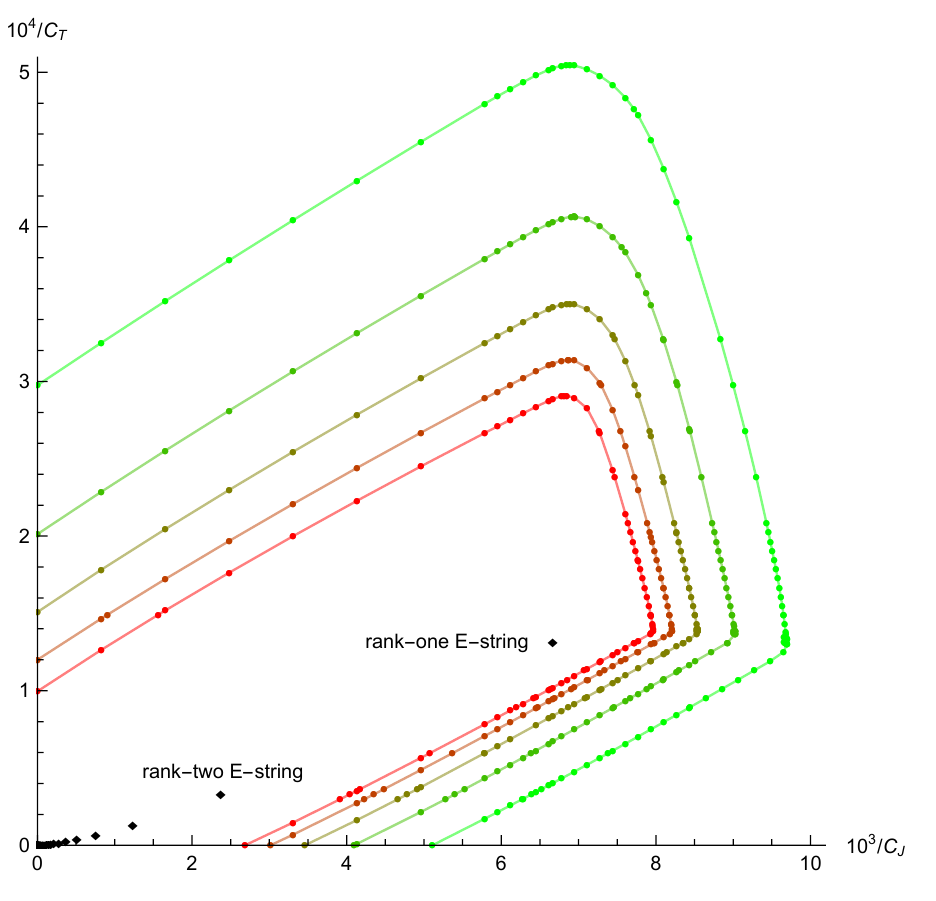
Figure 4 . The allowed region in the C (cid:0) 1 group, at derivative orders (cid:3) = 24 ; 28 ; : : : ; 40, shown from green to red. Also plotted are the points corresponding to the E-string